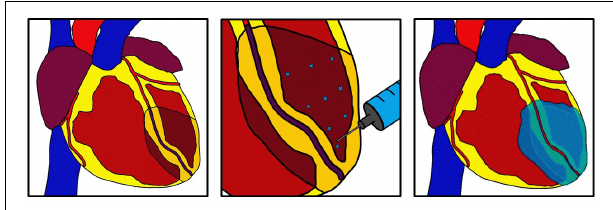
FIGURE 2 | Intramyocardial injection. After myocardial infarction a hydrogel derived from multiple possible sources is injected into the superficial myocardial using multiple injections. The hydrogel can distribute beyond the infarct zone and into the border zone. The hydrogel can act as a bulking agent to restore myocardial structure or can deliver growth factors to targeted areas. This technique can be used in concomitance with